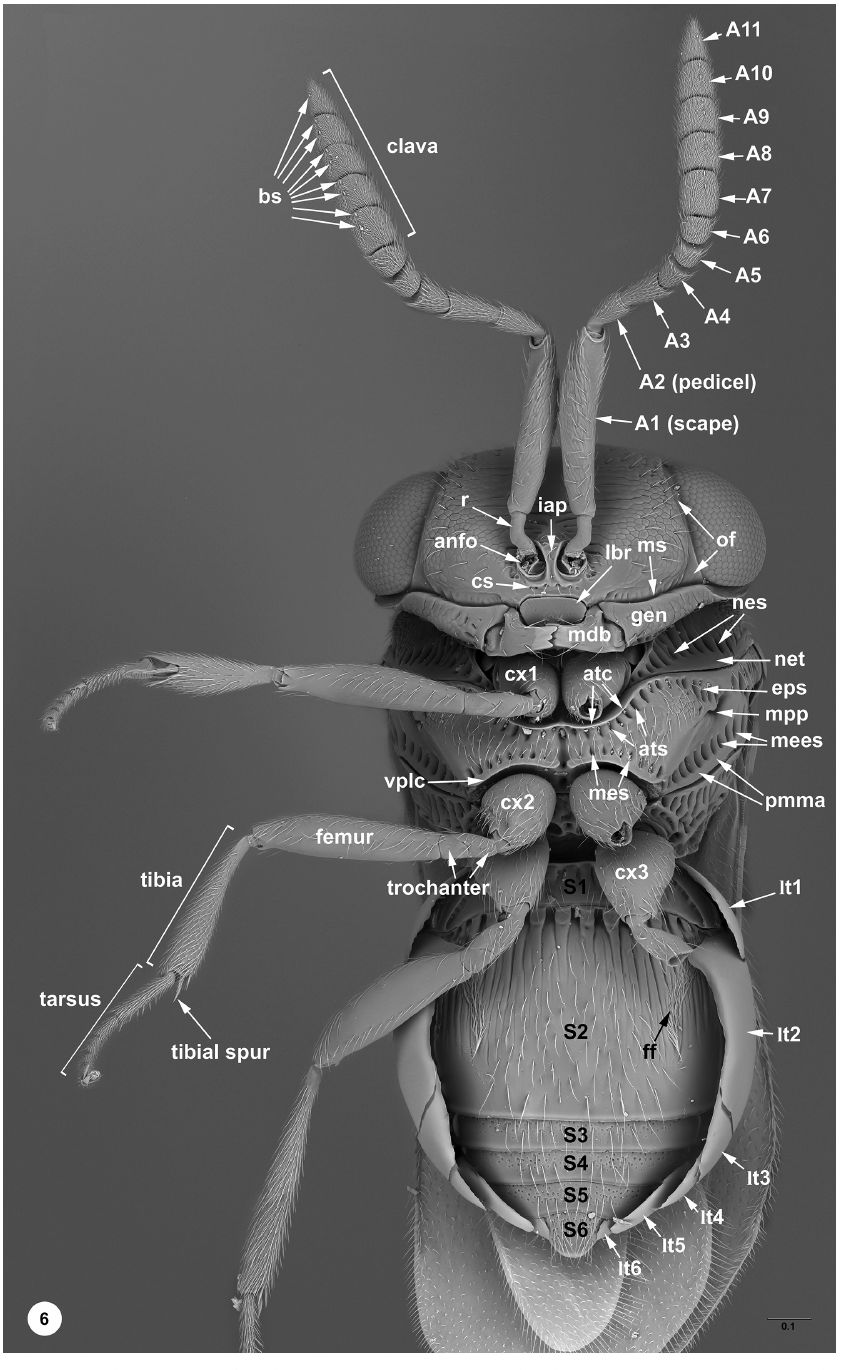
Figure 6. Trissolcus japonicus , female (USNMENT00896000), head, mesosoma, metasoma, ventral view. Scale bar in